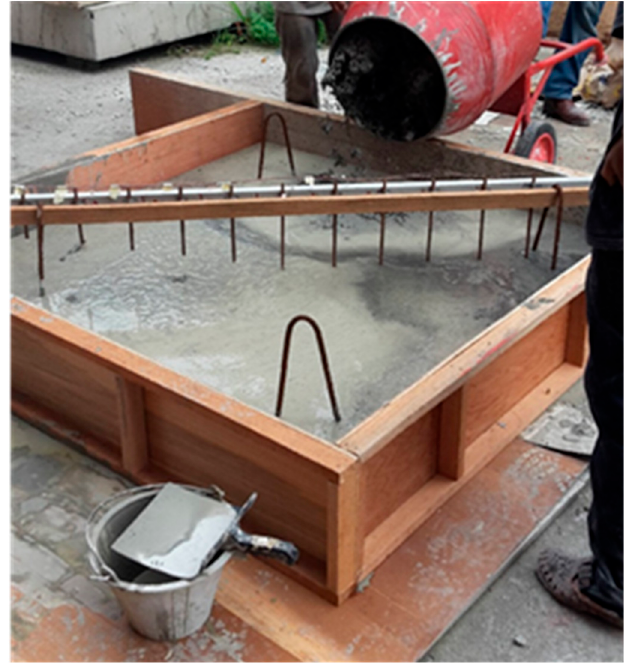
Figure 2. Formwork for 1200 × 1200 × 300 mm slab casting and thermocouples.